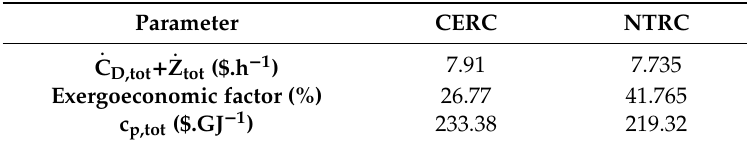
Table 11. CERC and NTRC exergoeconomic